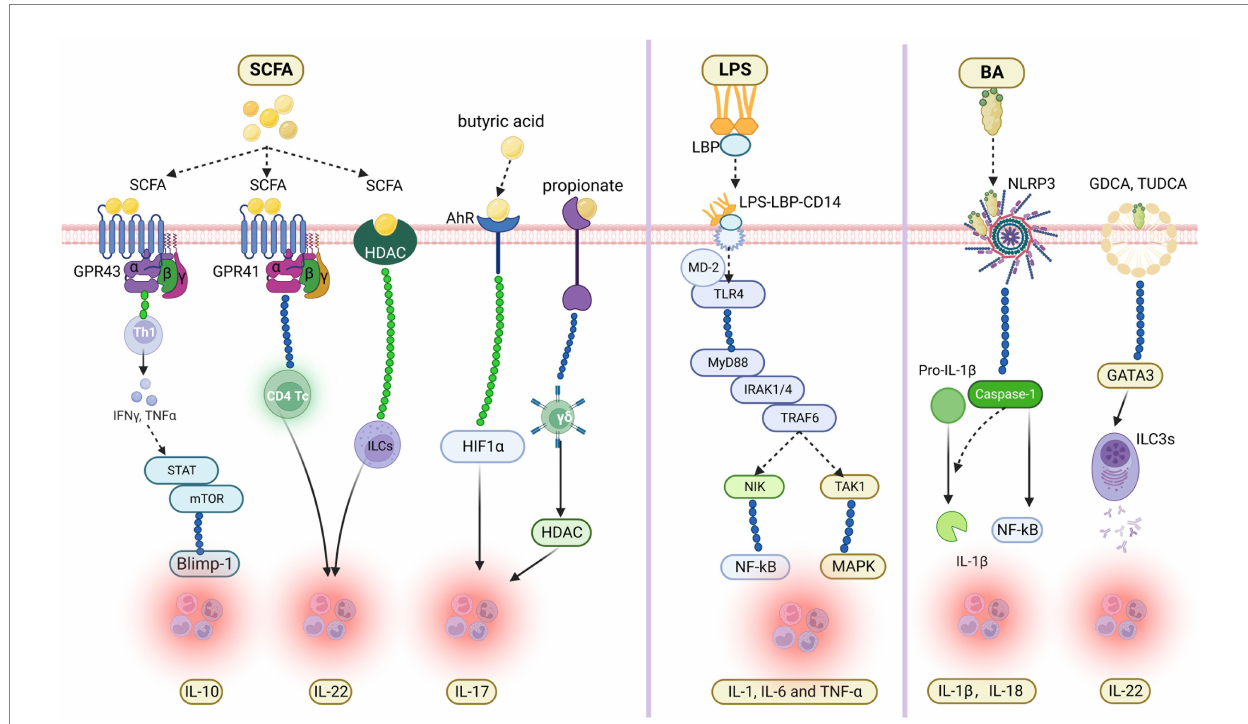
FIGURE 1 Molecular mechanism of gut microbial metabolites regulating the expression of specific interleukin in inflammatory immune